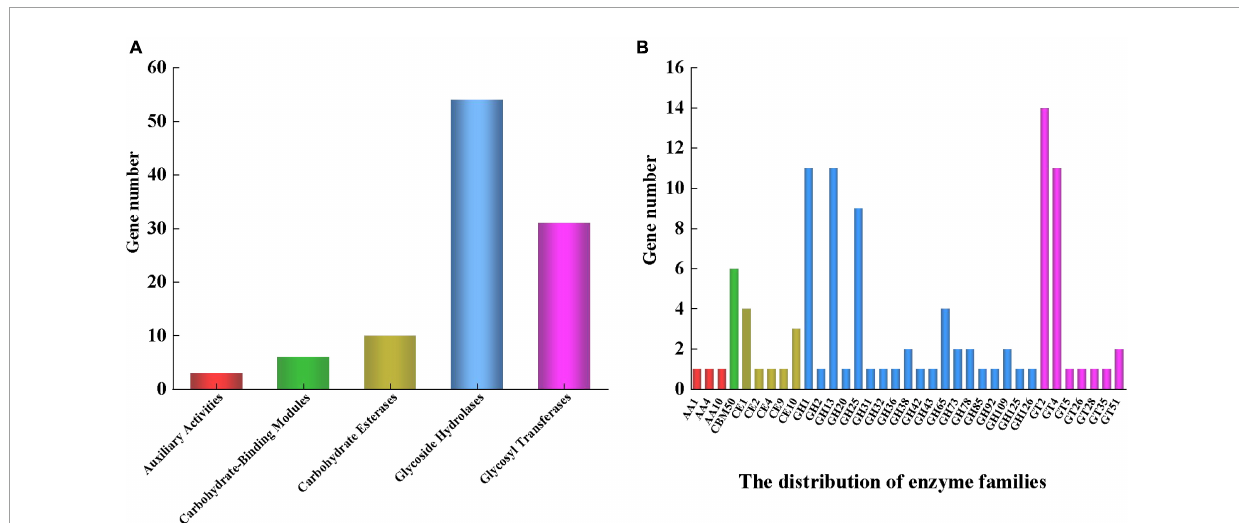
FIGURE4 (A) CAZy functional annotation of Lp. plantarum MC5. (B) Distribution of related genes. Red, green, yellow, blue, and purple represent auxiliary activities, carbohydrate-binding modules, carbohydrate esterases, glycoside hydrolases, and glycosyl transferases, respectively.